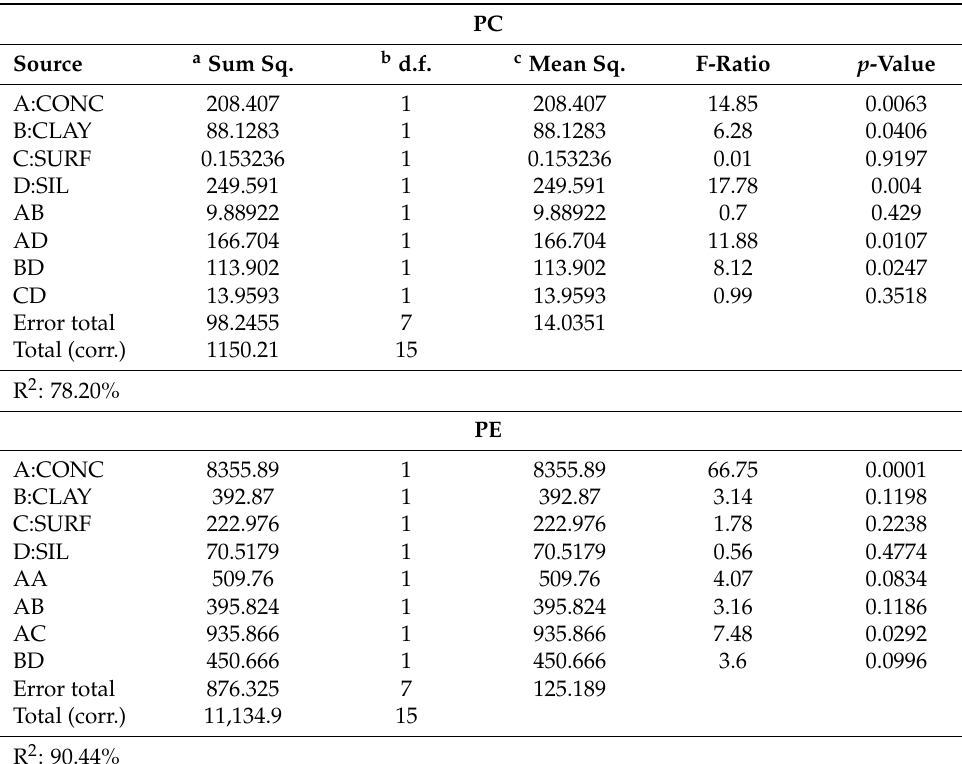
Table 3. Analysis of variance from PC and PE adsorptions (%) under DOE